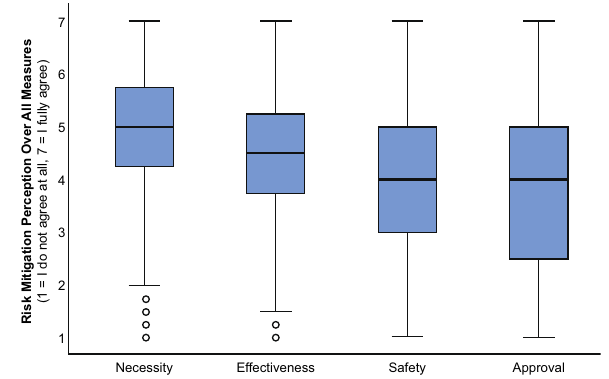
Fig. 2 Itemized perception of risk mitigation measures (average of the four mitigation measures traffic light, structural retrofitting, insurance, and relocation, N =